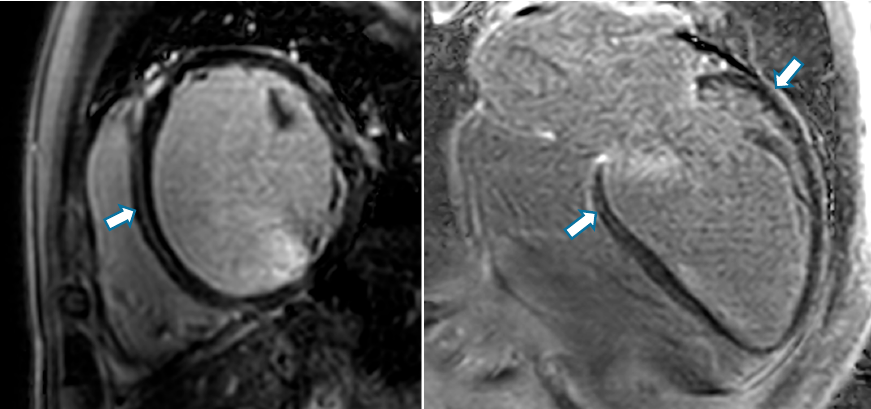
Figure 2. Cardiovascular magnetic resonance (late gadolinium enhancement sequences) shows sub- epicardial late gadolinium enhancement (white arrows) in axial (left) and longitudinal view (right). In most patients with sustained and hemodynamically not tolerated VT, MRI is lim- ited by artifacts from implanted ICDs for secondary prevention, and although scar detec- tion and ECV imaging by cardiac CT are possible, data are still scarce compared to CMR, and it is not performed in clinical routine [103,104]. Endomyocardial biopsy is used in selected cases in clinical routine, and serum markers are under evaluation in clinical stud- ies [105]. The analysis of LGE patterns render the identification of patients with non-is- chemic causes possible, as those patients show non-ischemic patterns including mid- wall/sub-epicardial or patchy distribution, in contrast to ischemic patterns in cardiomyo- pathies [106]. Fibrosis itself has been identified as a risk factor for mortality in DCM patients as the presence of LGE has been associated with increased VT occurrence and with overall mor- tality [107,108]. In addition, the complexity and extent of myocardial scars have been as- sociated with VT incidence and mortality [109,110]. The computer-based modeling of reentry circuits in individual patients may help to identify patients at risk for arrhythmia and support the planning of catheter ablation strategies [111]. 6. Translational Perspective and Conclusions The individualized risk prediction and treatment of patients with DCM remain chal- lenging. The optimal pharmacological treatment according to current guideline recom- mendations forms the basis of DCM therapy [9,112]. Yet, the current treatment of HF in